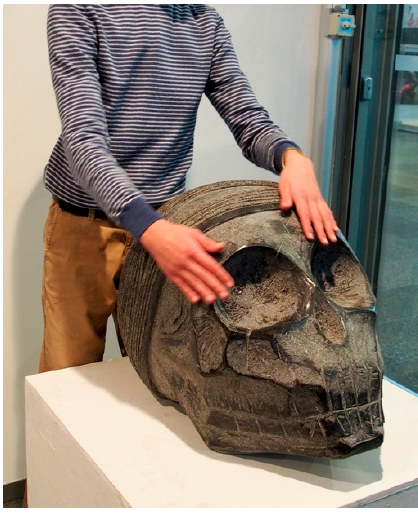
Figure 2. A deafblind visitor at the exhibition at Sanomatalo, 2016. Photo: The Finnish Deafblind Association Archive.